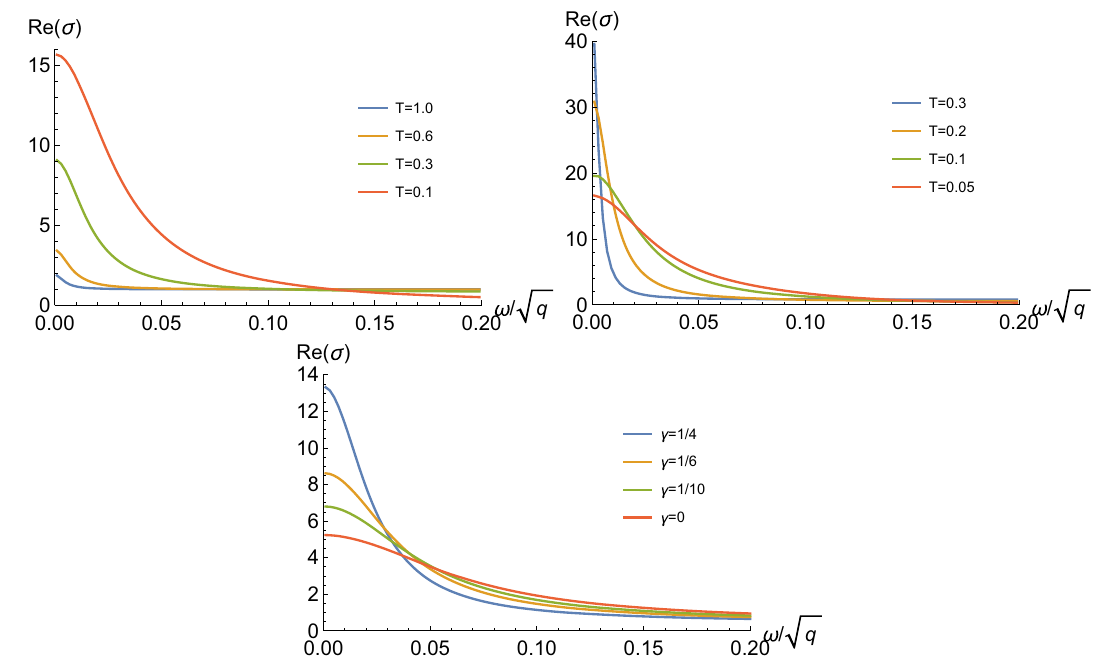
Fig. 4 The dependance of the real part of AC conductivity on frequency for different temperatures or couplings. Top left: we have fixed γ = 1 / 4. Top right: we have fixed γ = 1 / 3 . 01. Bottom: we have fixed T = 0 . 2